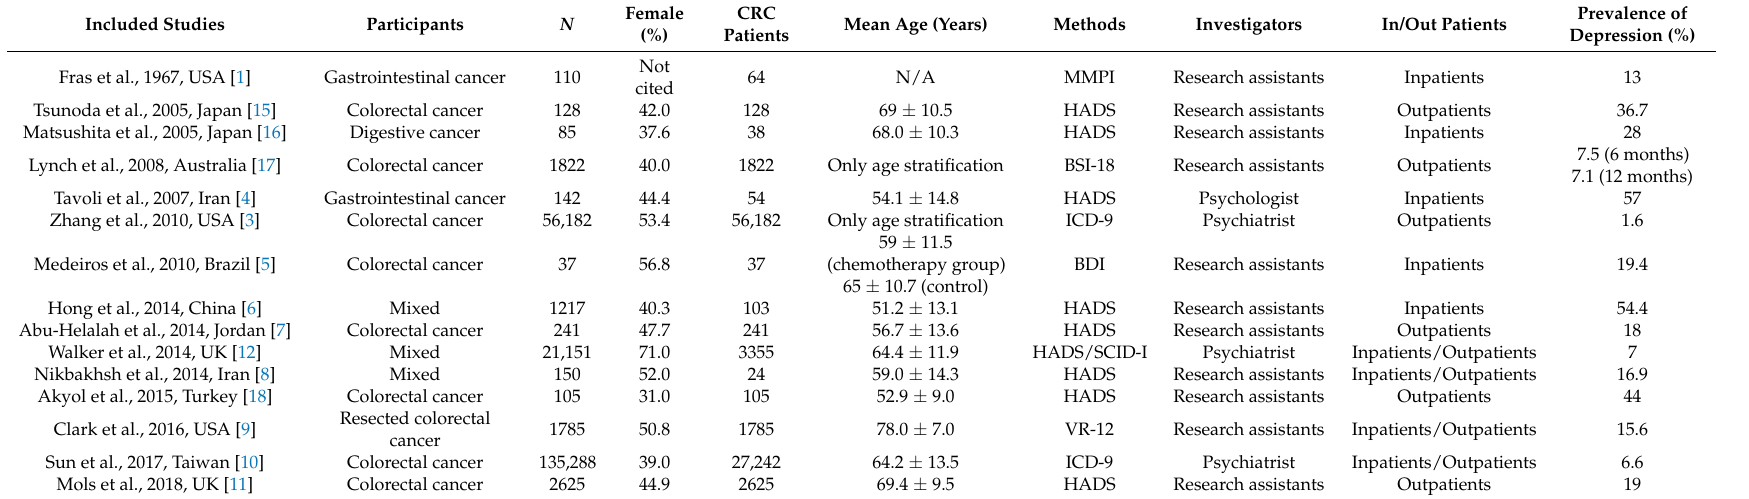
Table 1. Characteristics of included studies for prevalence of